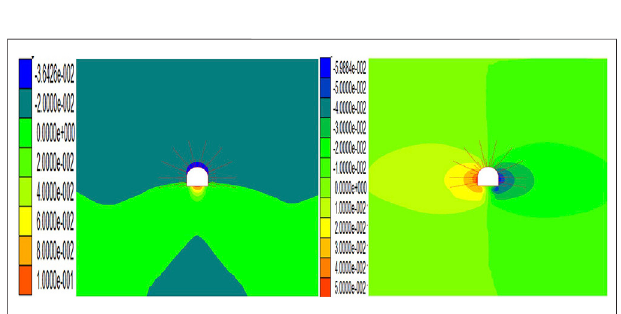
FIGURE 13 | Anchor rope (rod) – a single arch truss support